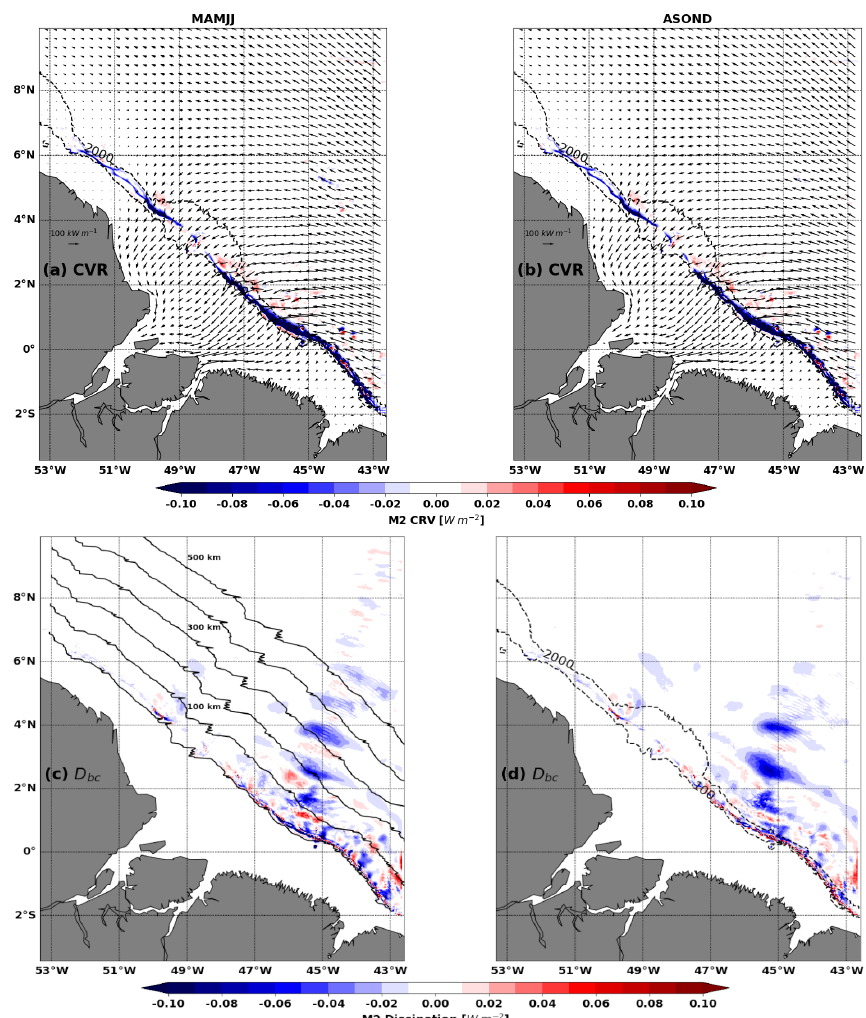
Figure 6. Top: M2 conversion rate (CVR, colour, units: Wm − 2 ) and barotropic flux ( F bt , arrows, units: Wm − 1 ). Bottom: dissipation of M2 coherent (colours, D , units: Wm − 2 ). Left column is for MAMJJ (a, c) and right column is for ASOND (b, d) . Dashed black contours are 100 and 2000m isobaths. The black solid contours are parallels to the 100m isobath drawn every 100km and along which the integrations are performed for Fig.